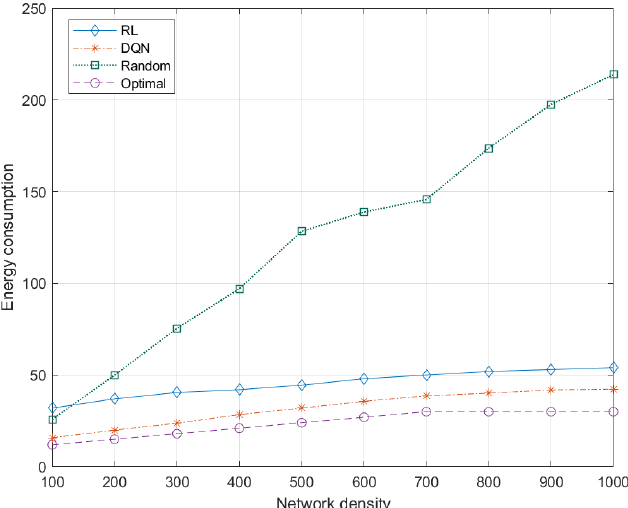
Figure 9. Energy consumption increases with respect to network density. DQN achieves lower values as compared to RL and random approaches. Lower energy consumption improves the energy efficiency of a